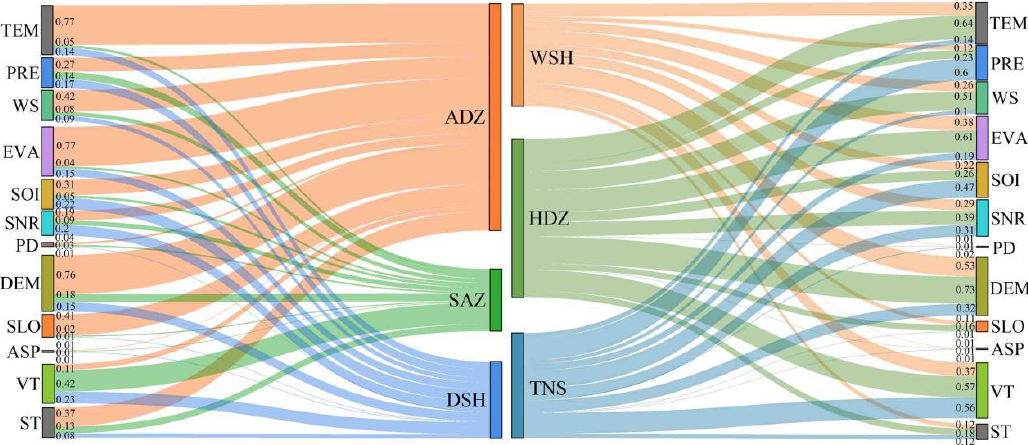
Figure 7. Contribution of drivers to VEQI in the TNS and each climate zone.